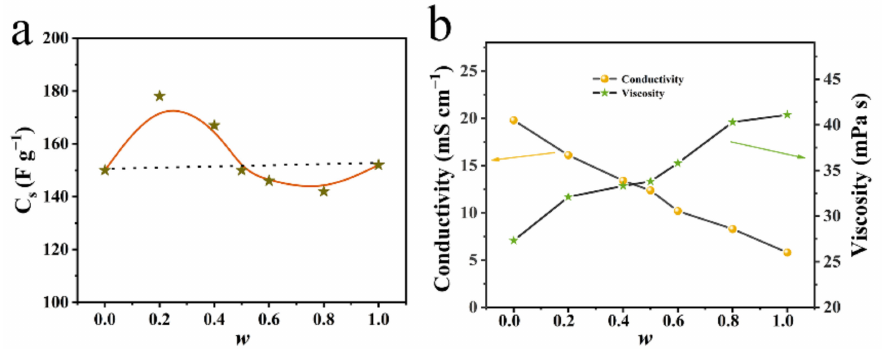
Figure 3. Plots of ( a ) specific capacitance and ( b ) conductivity/viscosity vs. the mass fraction w of the binary IL mixtures ([Bmim][TFSI] w [Emim][BF 4 ] 1- w ) at 30 ◦